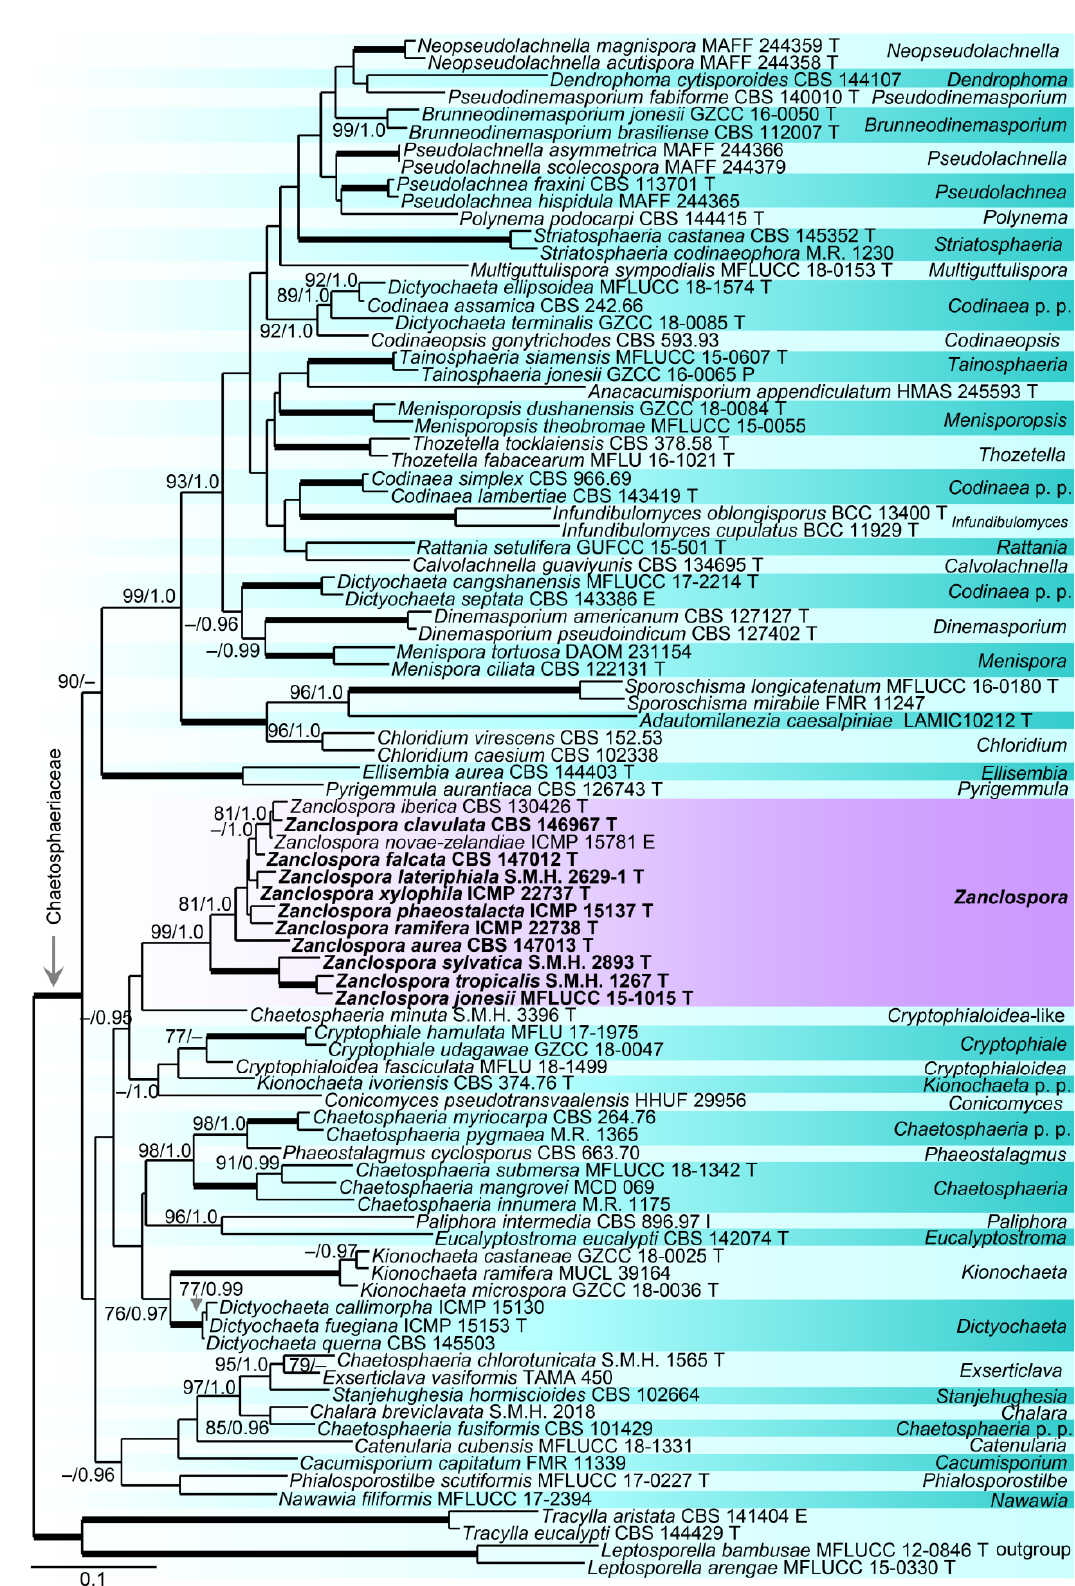
Figure 2. Combined phylogeny using ITS and 28S of members of the Chaetosphaeriaceae. Species names given in bold are taxonomic novelties; T, E, I and P indicate ex-type, ex-epitype, ex-isotype and ex-paratype strains. Thickened branches indicate branch support with ML BS = 100%, PP values = 1.0. Branch support of nodes ≥ 75% ML BS and ≥ 0.95 PP is indicated above or below branches. Abbreviation: p.p. after a genus name (pro parte).